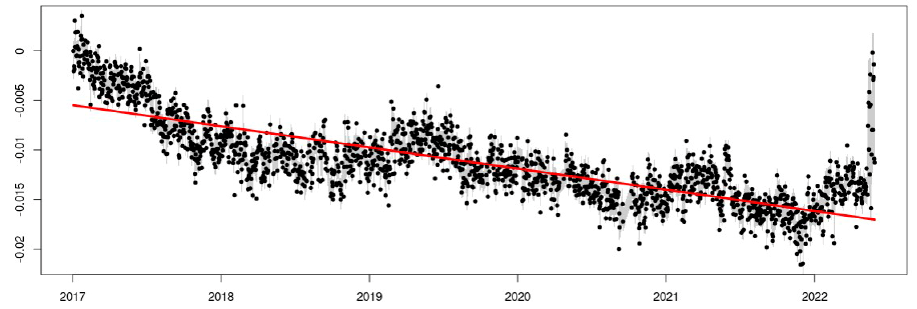
Figure 6. Trend fit for the eastern component of the EPEC station time series. The time series is adjusted with a simple straight line describing a decreasing trend.